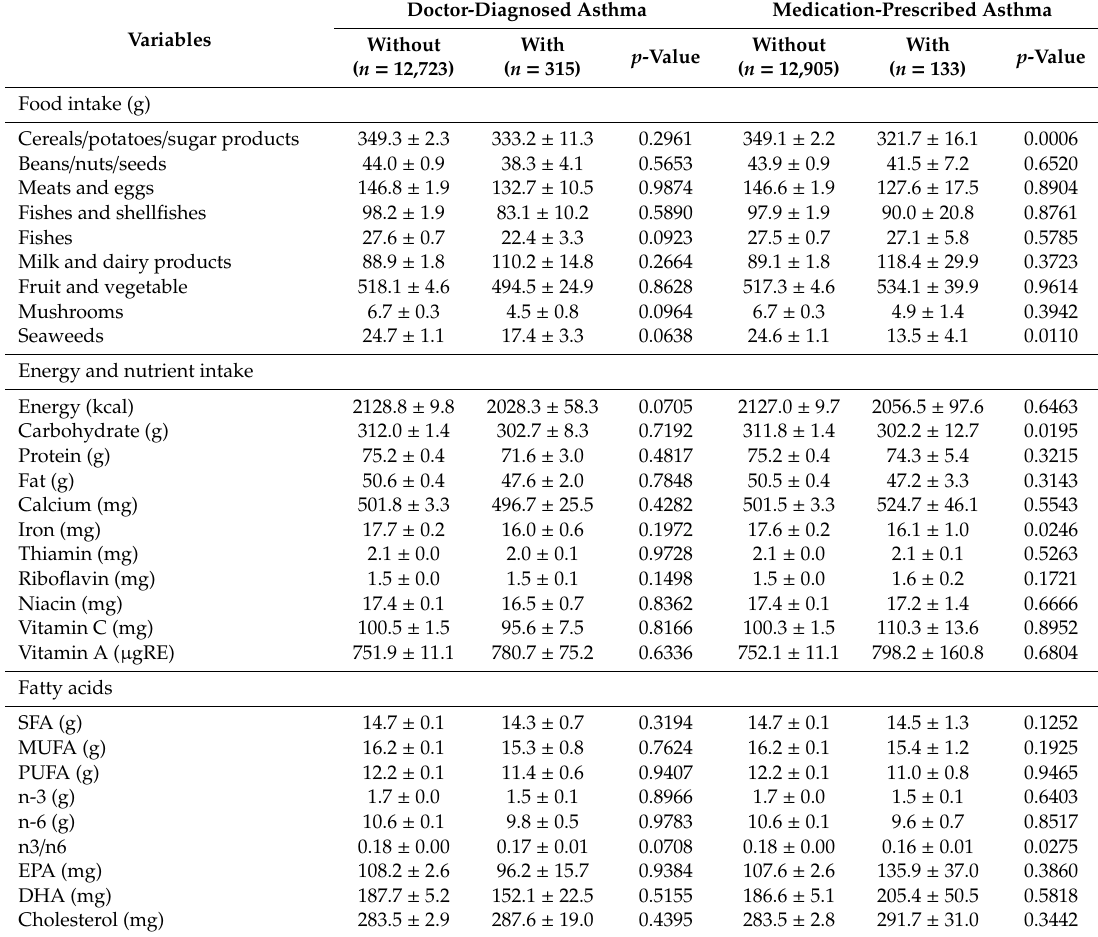
Table 2. Daily food and nutrient intakes of the subjects according to